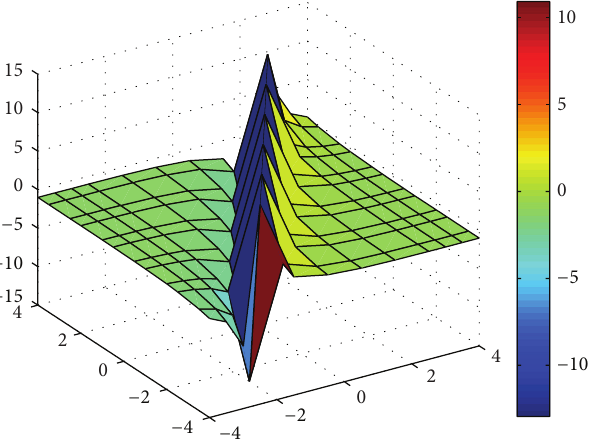
Figure4:Thesolitarywaveandbehaviorofthesolutions 𝑢(𝑥, 𝑦,𝑡) = −1 + 2 csch (𝑥 − 2/3𝑦 + 𝑡) for 𝑡 = 0 , −4 ⩽ 𝑥 ⩽ 4 , and −4 ⩽ 𝑦 ⩽ 4 .